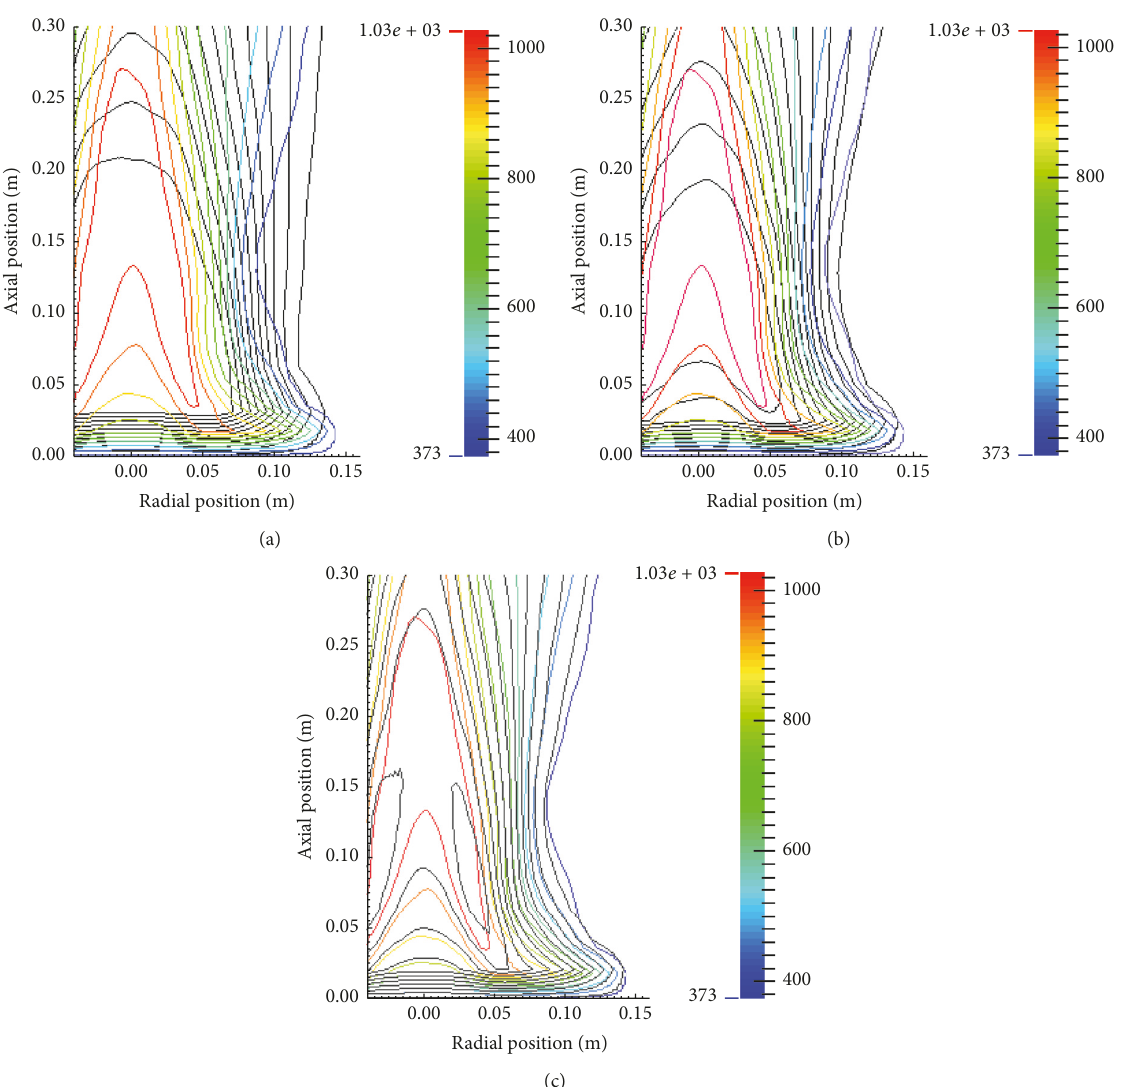
Figure 15: Numerical average temperature [K] contours (scales in meters): (a) mesh C versus mesh SF; (b) mesh M versus mesh SF; (c) mesh F versus mesh